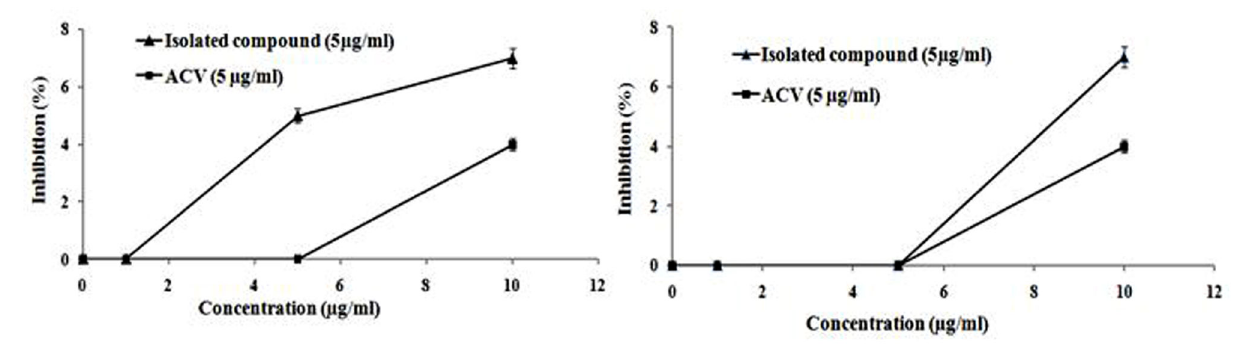
Figure 3. Effect of HM and ACV on HSV-2 attachment and penetration. [A] Attachment assay : Prechilled cells at 4°C for 1 h were infected with HSV-2G (200 pfu) and then untreated or treated with HM. After incubating at 4°C for another 3 h, the medium was aspirated, washed and overlaid with methylcellulose to form plaques. The plaques developed after 72 h were stained and counted. [B] Penetration assay : Prechilled cells at 4°C for 1 h was infected with HSV-2G (300 pfu) for 3 h at 4°C and then untreated or treated with HM (5µg/ml) or DMSO (0.1%), and incubated for 20 min at 37°C to facilitate viral penetration. Then the extracellular non-penetrated virus was inactivated by citrate buffer (pH 3.0) for 1 min, washed with PBS and overlaid with overlay medium to form plaques. The plaques developed were then stained and counted.